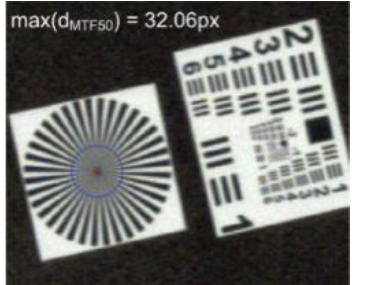
Figure 9: Resolution test charts in-flight (original resolution) The resolving power has been determined pre-flight (static conditions) and in-flight (kinematic conditions) with the same pattern. A Siemens star and an USAF resolution target have been used for the evaluation, whereas the estimated MTF10 values are derived from the Siemens star only. The UASF pattern only serves as sort of comparison. Figure 9 shows one image from the flight. The MTF50 circle is overlaid to the Siemens star. A mean resolution (MTF10 value) of 17.4 mm from Siemens star here would correspond to about 18 mm from the USAF target, depending on which person reads the later from the target. Thus, only the quantified image resolutions MTF10 from Siemens star analysis are shown in the Figure 10 and 11 for the static and kinematic environment.